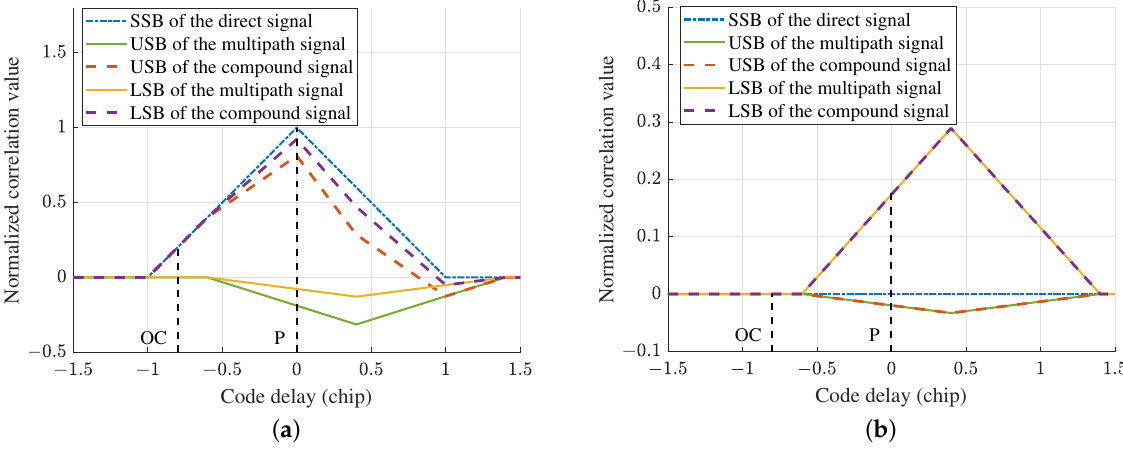
Figure 3. Schematic diagram of the multipath effect on the offset correlator (OC) and the prompt (P) correlator: ( a ) in-phase correlation functions; ( b ) quadrature-phase correlation